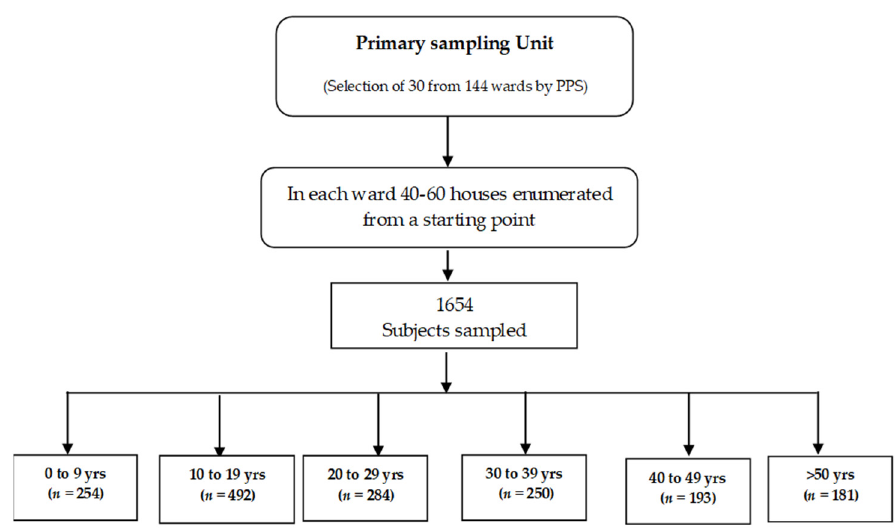
Figure 2. Flowchart for sampling design and profile of study participants.